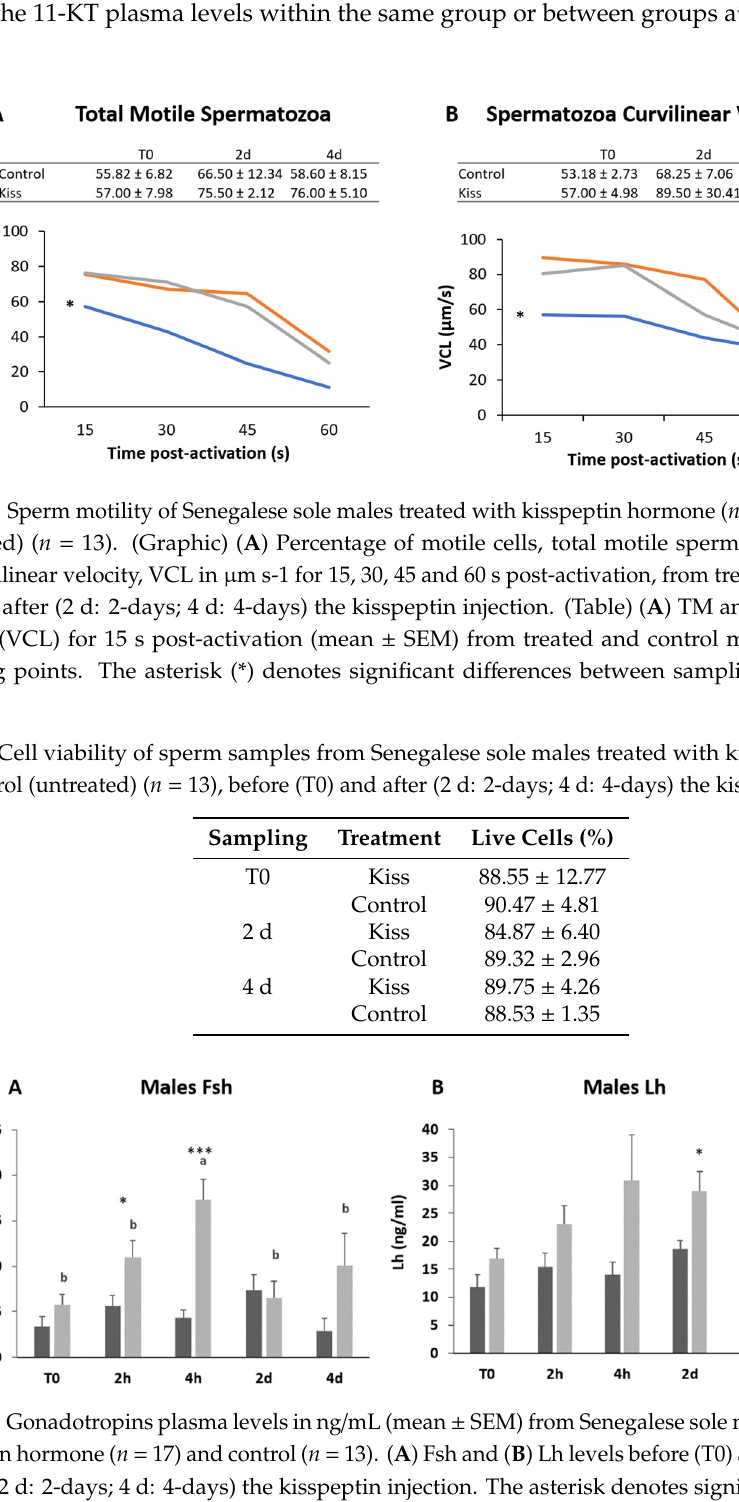
Figure 6. Sexual steroids plasma levels in ng/mL (mean ± SEM) from Senegalese sole males treated with kisspeptin hormone ( n = 17) and control ( n = 13). ( A ) Testosterone and ( B ) 11-Ketotestosterone